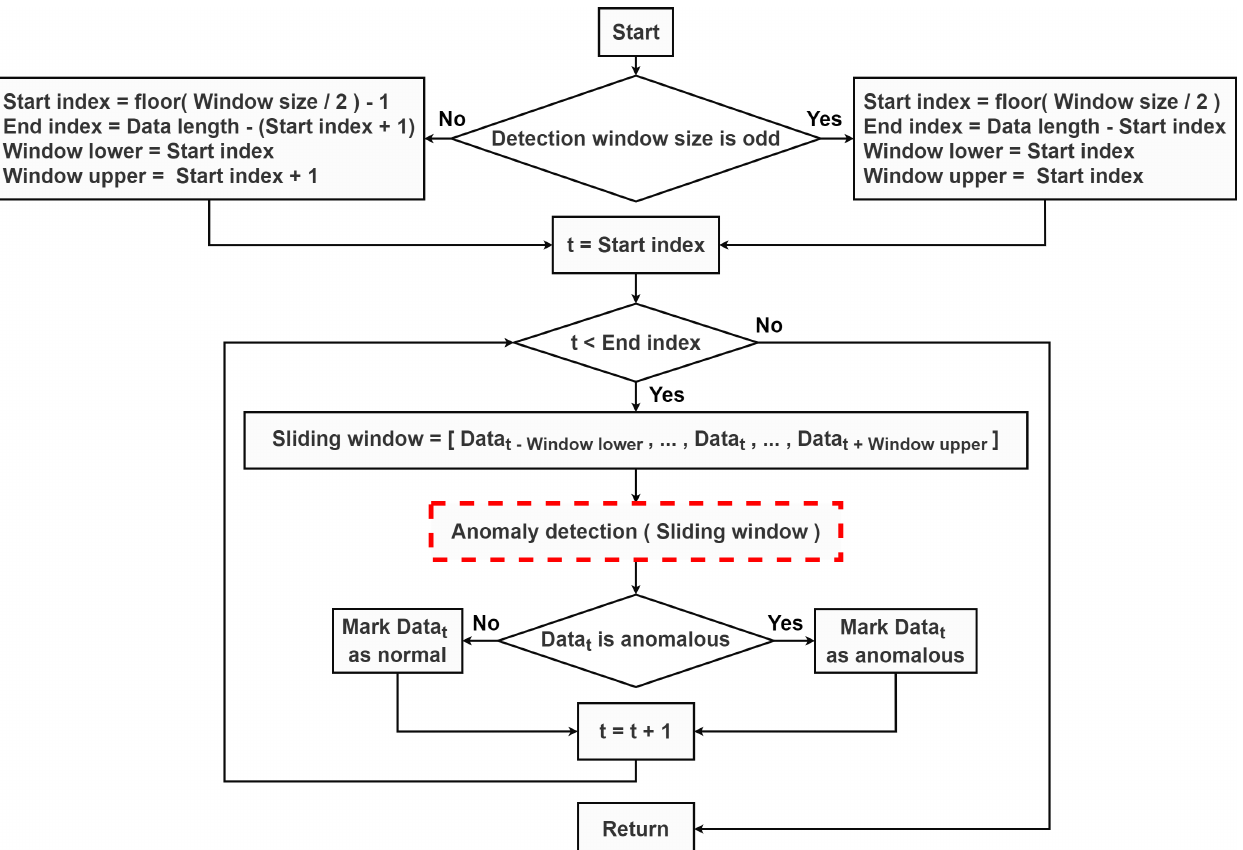
Figure 1. A flow chart of the anomaly detection process.